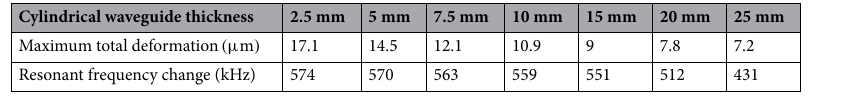
Table 4. Maximum deformation of cavity for different cylindrical waveguide